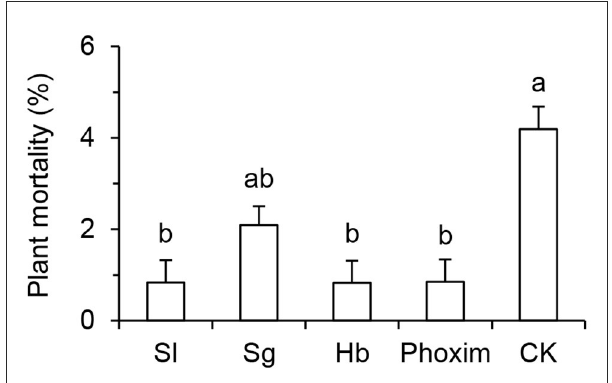
FIGURE3 Plant mortality observed in different plots treated with Steinernema longicaudum X-7 (Sl), S . glaseri KG (Sg), and Heterorhabditis bacteriophora H06 (Hb) at 1.5 × 10 9 IJs/ha, and phoxim at 4,500 mL/ha evaluated on May 13, 2022. Different letter(s) on the